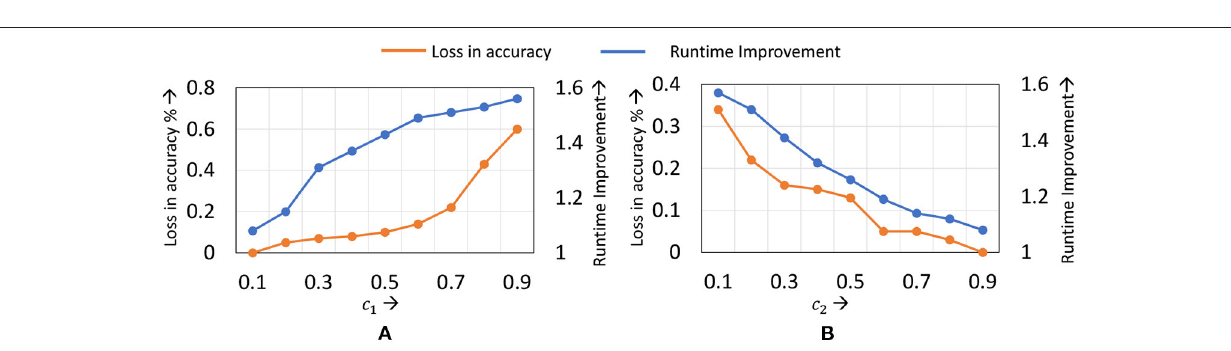
Frontiers in Neuroscience |